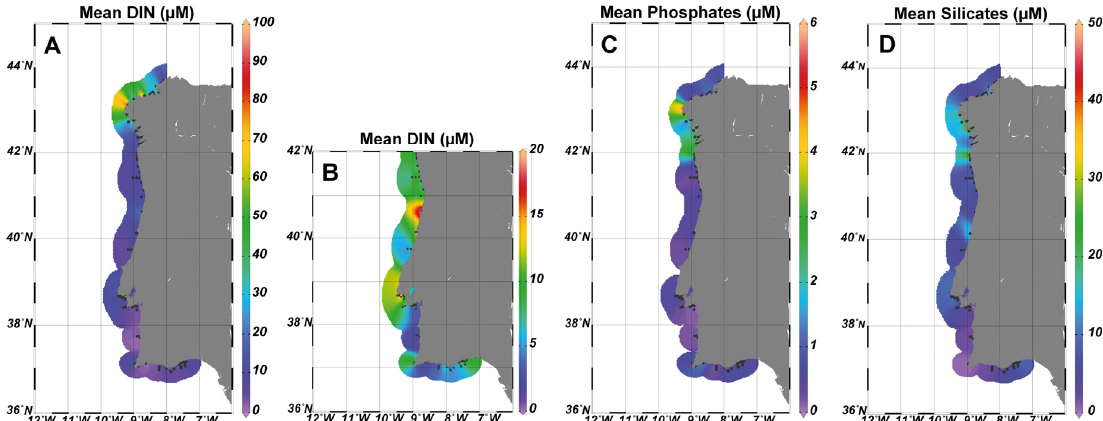
Figure 7. In situ mean winter nutrient concentrations ( µ M): ( A ) Dissolved inorganic nitrogen at the Western Iberia (WI) region; ( B ) Dissolved inorganic nitrogen at the Portuguese area; ( C ) Phosphates at the WI region; ( D ) Silicates at the WI region. Please note the different scales.